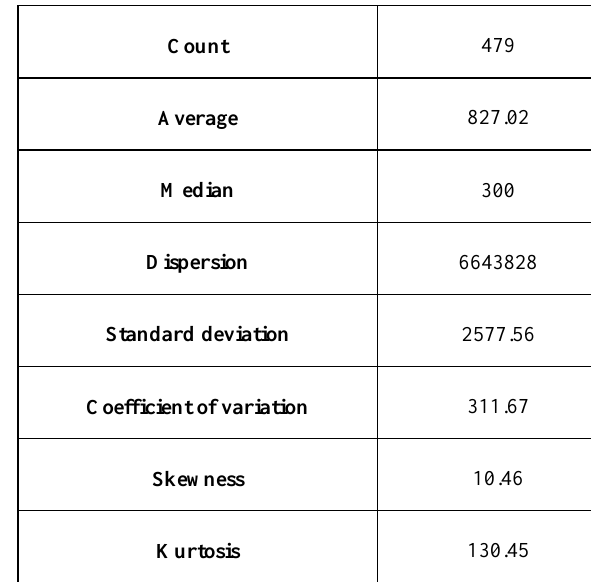
Table 2. Summary statistics for insured losses of natural